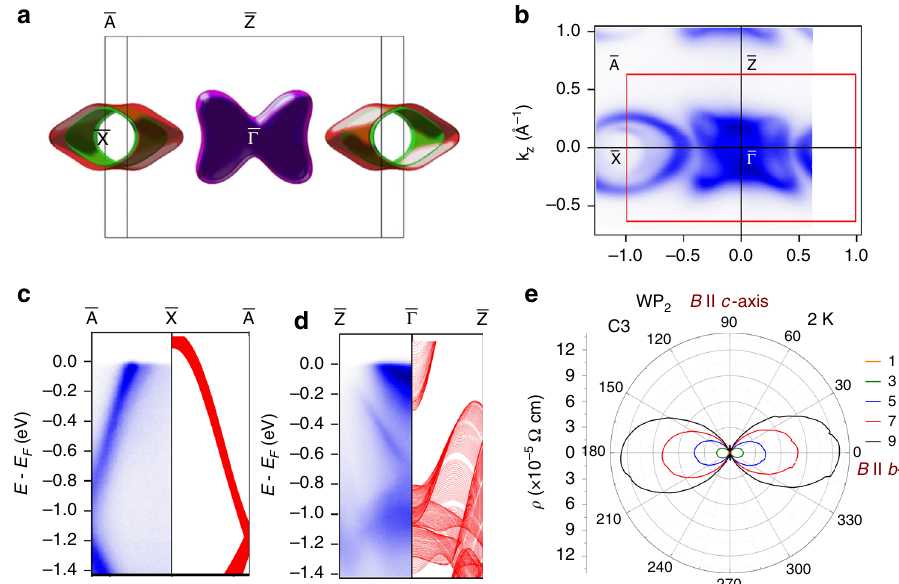
Fig. 3 Electronic structure, ARPES and corresponding anisotropic MR in WP 2 . a Projection of calculated Fermi surface on the ac -plane. Spaghetti-like open hole Fermi surfaces located around X-point in the BZ, extending along the b -axis. Bow-tie-like closed electron Fermi surfaces located around Y-point in the BZ. b Fermi surface cross section of WP 2 along b -axis from ARPES measurements showing good correspondence with the calculated Fermi surface. c , d Comparison of energy dispersions from calculation (right) and ARPES measurement (left) along A (cid:1) X (cid:1) A and Z (cid:1) Γ (cid:1) Z , respectively. The calculated energy dispersions are projected to k y . e Anisotropy in the resistivity due to the Fermi surface topology. MR is the maximum and minimum when B is parallel to the b - and c -axis, respectively. I is applied along the a -axis. A small misalignment of the crystal in the bc- plane was corrected (see Supplementary Fig.